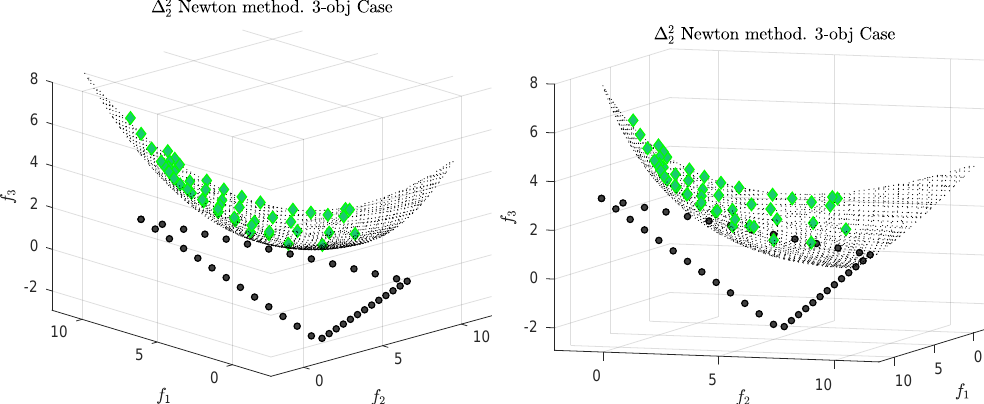
-Newton method for MOP (53), where Z is a line. 2